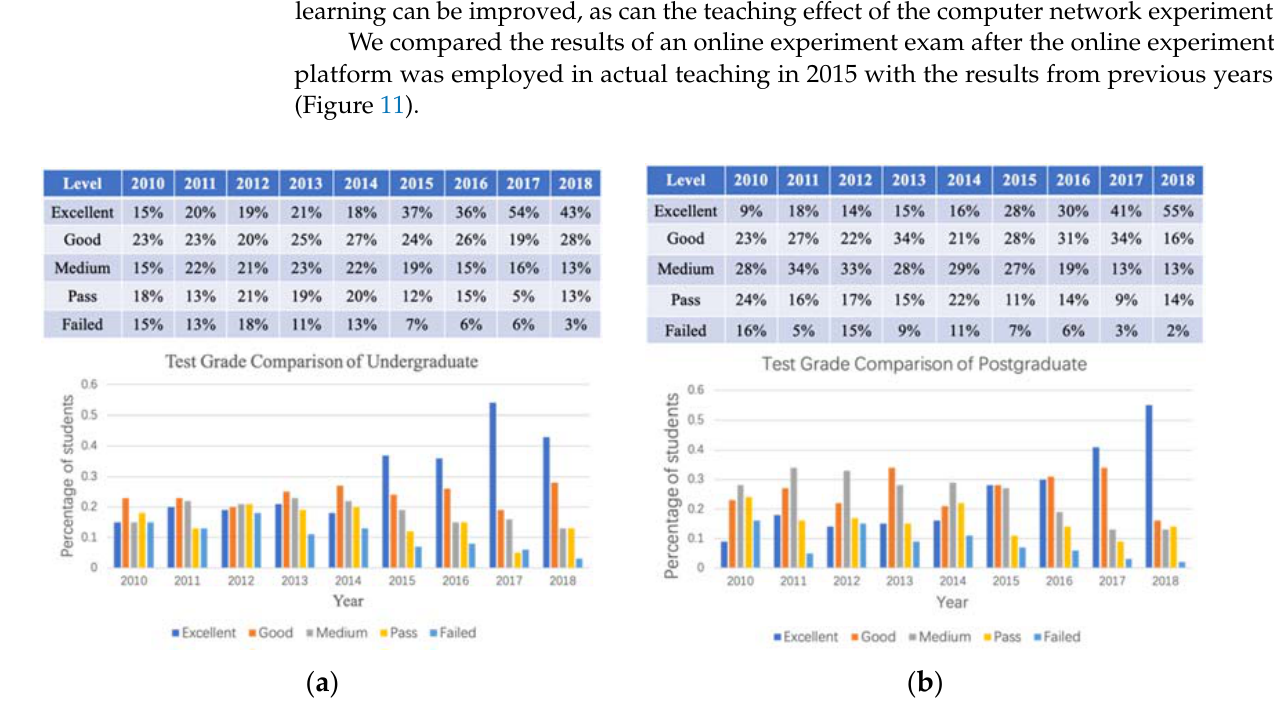
Figure 11. Comparison of exam grades. ( a ) Statistical comparison of undergraduates’ experimental exam grades. ( b ) Statistical comparison of postgraduates’ experimental exam grades.